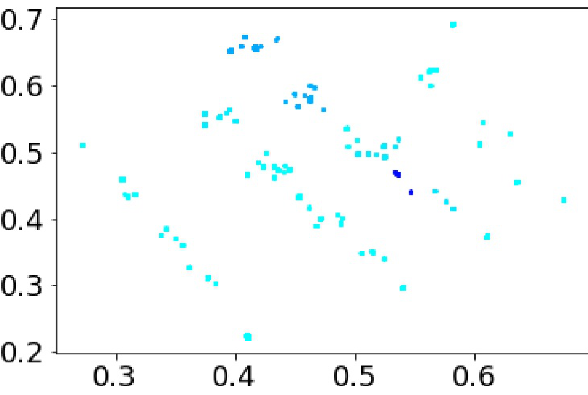
Figure 3 . Ratio of 3-generation models to n 6 = 0-generation models in each cluster, where the higher the ratio, the darker the color is. The horizontal and vertical axes represent the (cid:12)rst and second components of ~x b ,